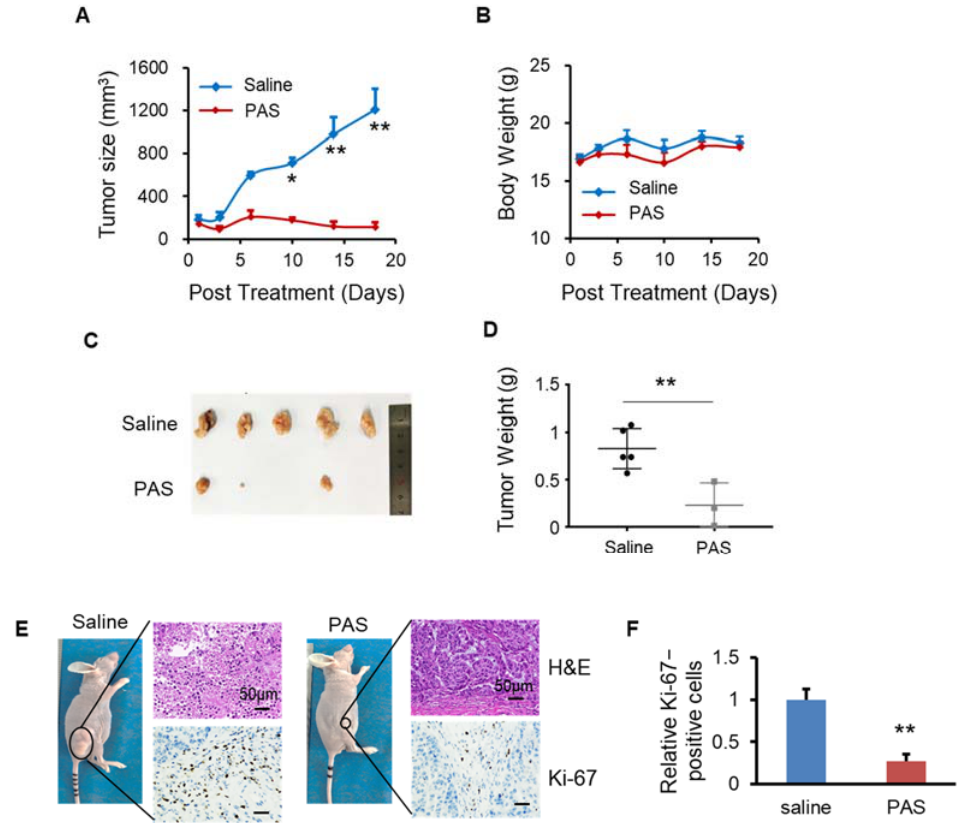
Figure 7. PAS injection significantly suppressed A549 xenograft tumor growth in vivo. Nude mice bearing A549 xenografts were grouped and treated with saline or PAS. The tumor size ( A ) and body weight ( B ) were measured. At the end of the experiment, tumors were harvested and weighed ( C , D ). Tumor sections were stained with H&E (upper panel), Ki-67 (lower panel) ( E ). ( F ) Quantitative analyses of Ki67 ‐ positive cells were performed with ImageJ. Data represent mean ± SD; n = 5; * p < 0.05; ** p < 0.01; scale bar = 50 μ m.